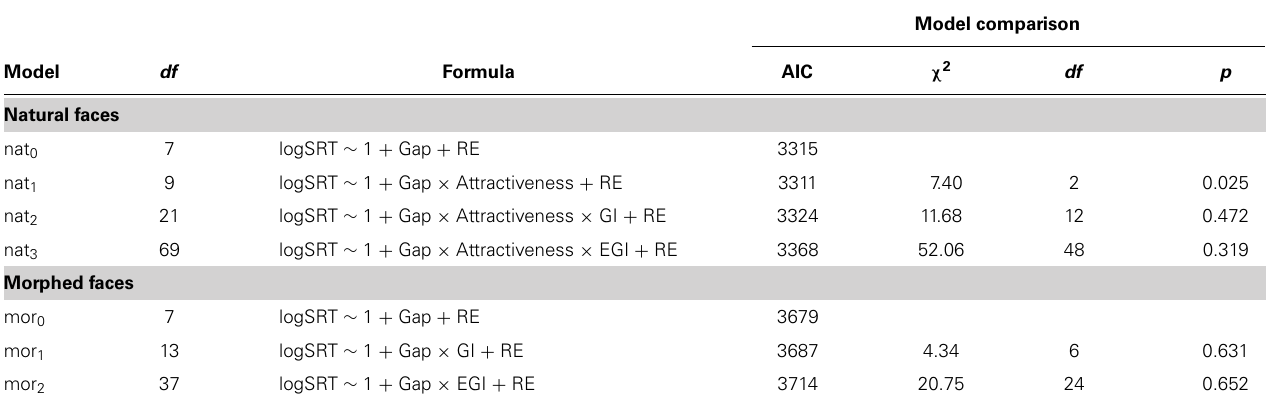
Table 3 | Comparison of nested LMMs fitted to log-transformed SRTs in Experiment